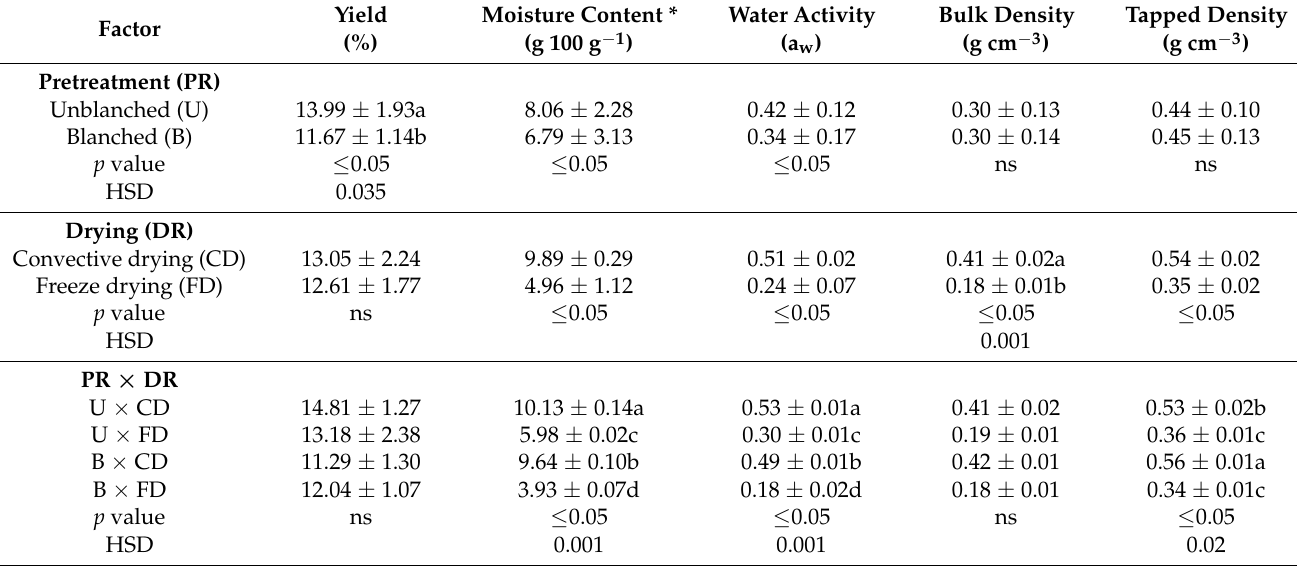
Table 1. The interaction of pretreatment and drying factors on the physicochemical and technological properties of nettle powders. Data are mean ± standard deviation of the mean. Mean values belonging to the same factor without common letters are statistically different according to the Honestly Significant Difference or HSD ( p ≤